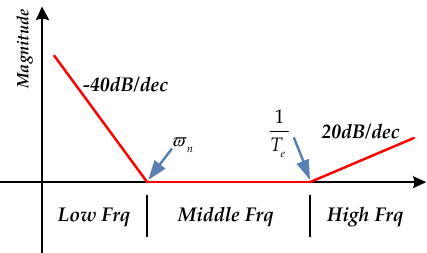
Figure 4. The diagrammatic sketch of the ideal disturbance observation and compensation (DOC) controller in frequency domain.